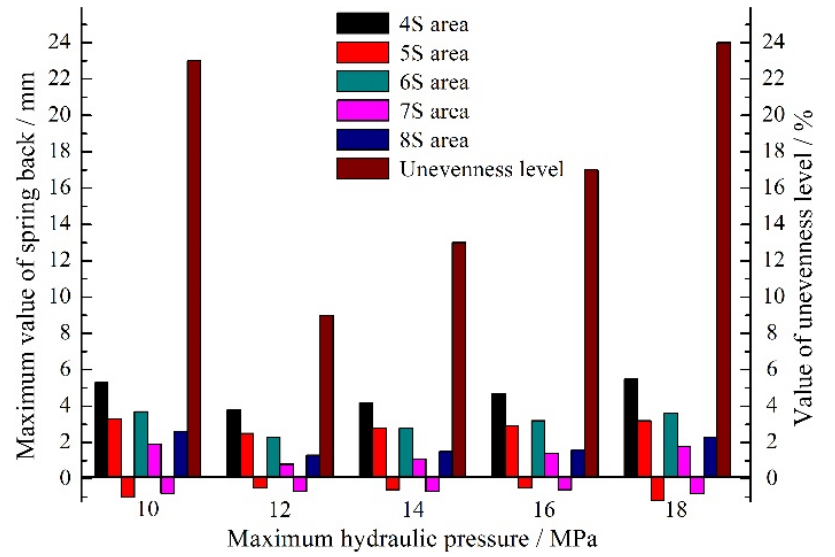
Figure 10. The maximum spring back values and unevenness level of wall thickness with different maximum hydraulic pressures.